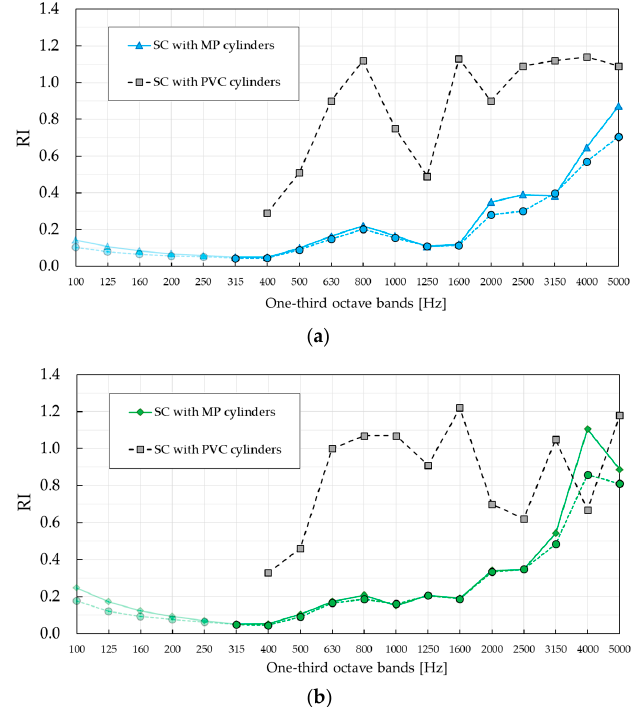
Figure 11. Sound reflection index reflection index ( RI) of the SC barrier with MP cylinders measured in two different configurations. The results are compared with results of the standardised characterisation of SC barrier with PVC cylinders presented in Figure 7 in [24]. ( a ) Reflection index RI , configuration A; ( b ) reflection index RI , configuration B.